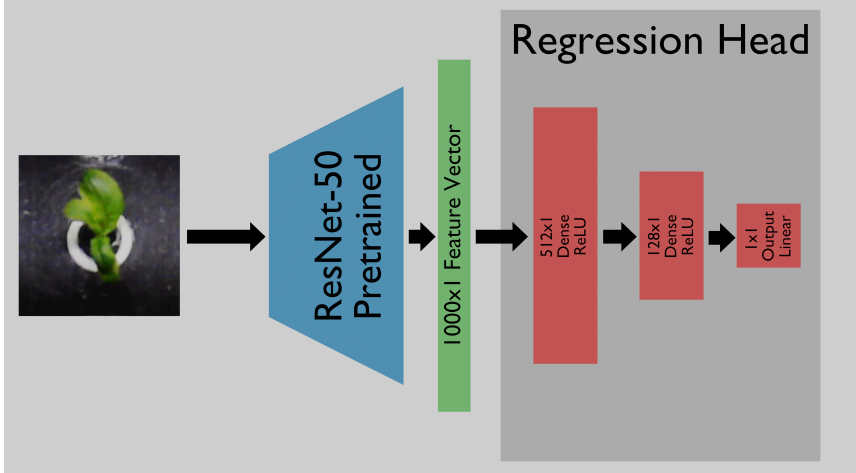
Figure 5. Graph of the architecture used for the R-50 network, including layer sizes, connection types, and activation